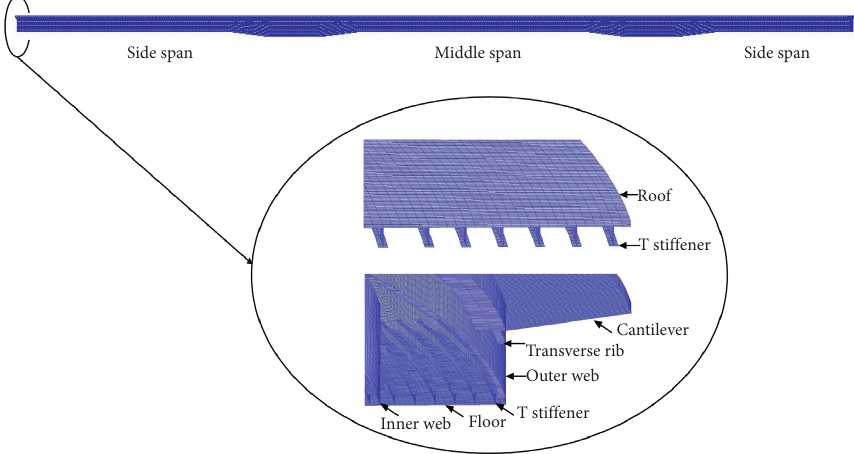
Figure 6: Schematic diagram of the